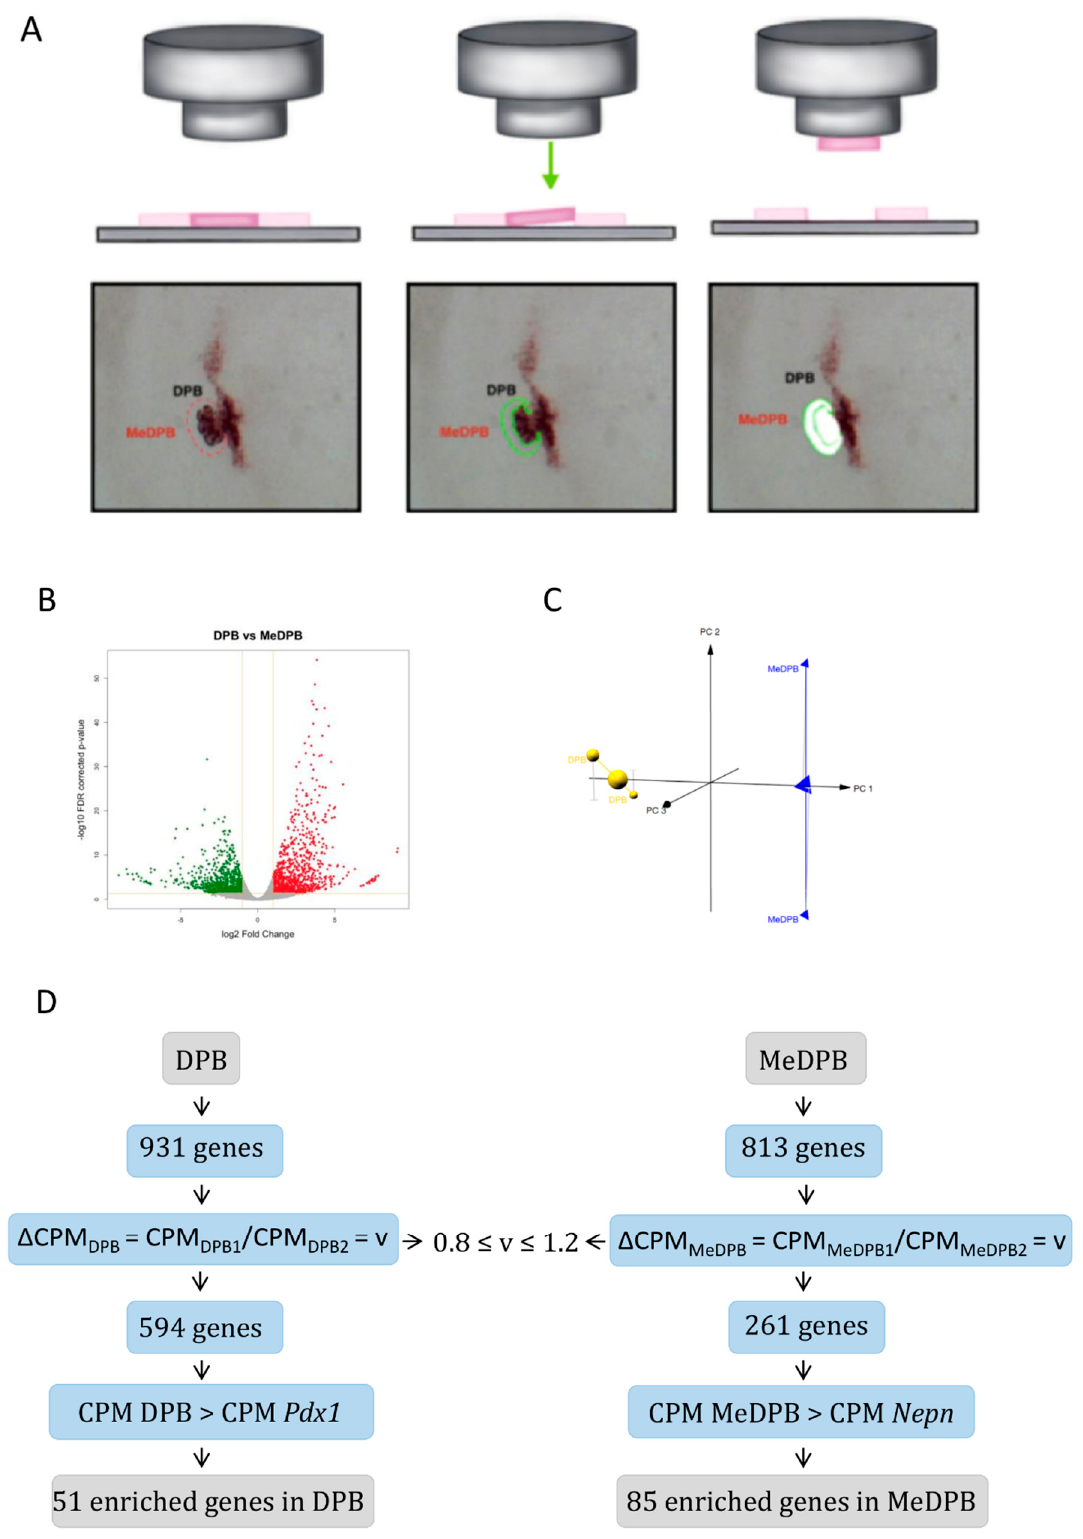
Figure 1. Capture of dorsal pancreatic bud and dorsal pancreatic mesenchyme by Laser Capture Microdissection. ( A ) Schematic representation of DPB and MeDPB dissection. Samples were collected by using the LCM technology at the embryonic stage E10.5. To reduce the biological variability, DPB and MeDPB from three embryos were collected and pooled. ( B ) Volcano plot of differentially expressed genes. Each dot on the plot is a single gene feature. Horizontal axis: fold change (in log2 scale); vertical axis: FDR-corrected p-value (in log10 scale). Color coding is based on the fold change.